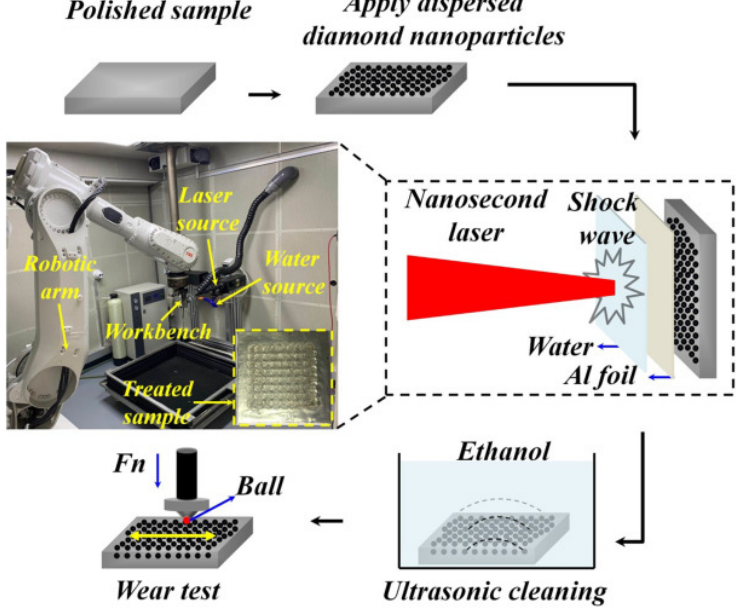
Figure 9. The experimental setup for the diamond nanoparticle implantation using LSP [102].